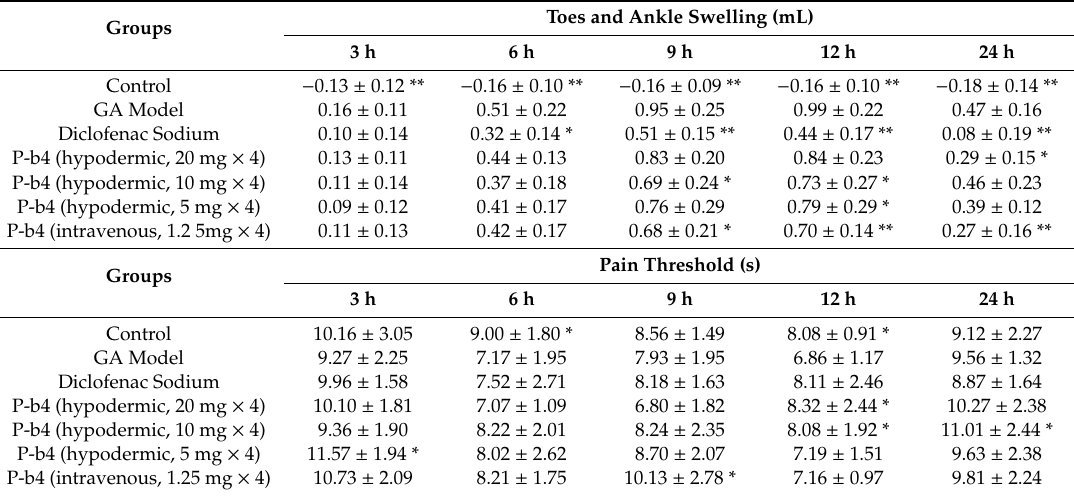
Table 1. E ff ect of each group on toes / ankle swelling and pain threshold in MSU crystal-induced GA rat model ( x ± s , n =